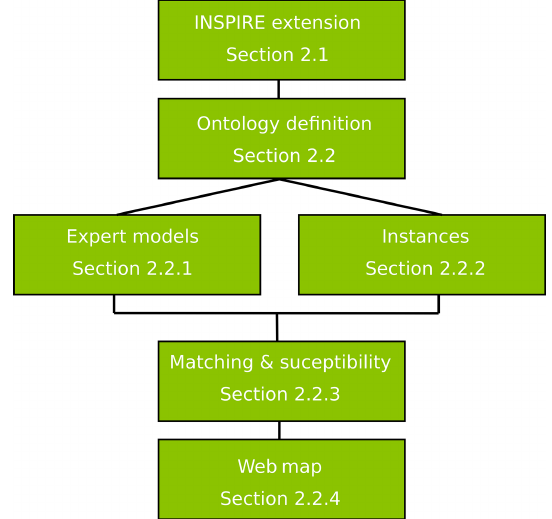
Figure 1. The workflow followed in this study and corresponding method sections. We extended INSPIRE, defined an ontology, ex- pert models and mapping instances. We compared models and in- stances to deliver a susceptibility map which is available